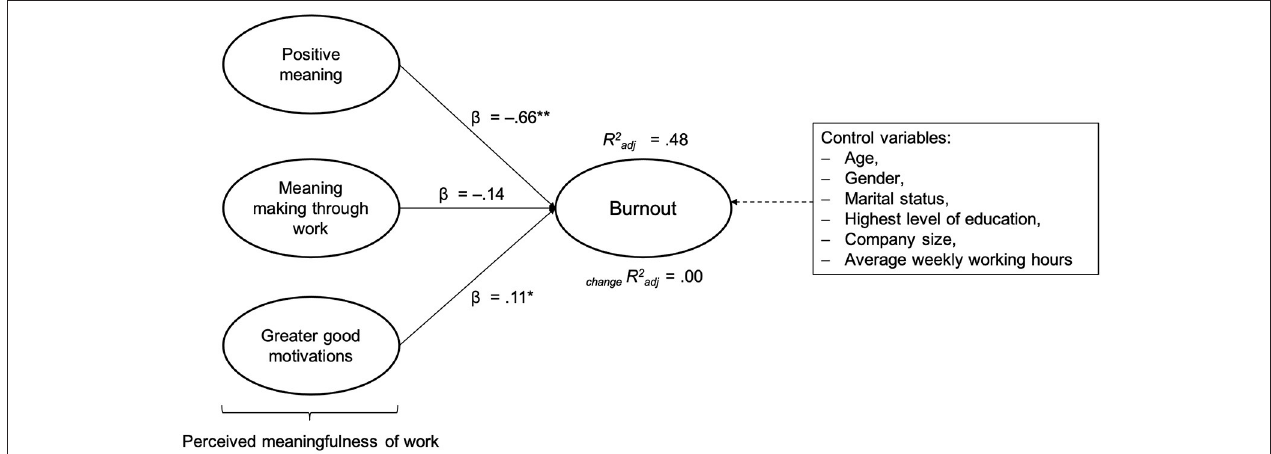
FIGURE 1 | Multiple regression analysis with the total burnout score as a dependent variable and positive meaning (PM), meaning making through work (MM), and greater good motivations (GG) as independent variables (step 1); change R 2 adj after incorporating the control variables (step 2). R 2 adj = R 2 adjusted; change R 2 adj = change in R 2 adjusted; * p < 0.05; ** p <